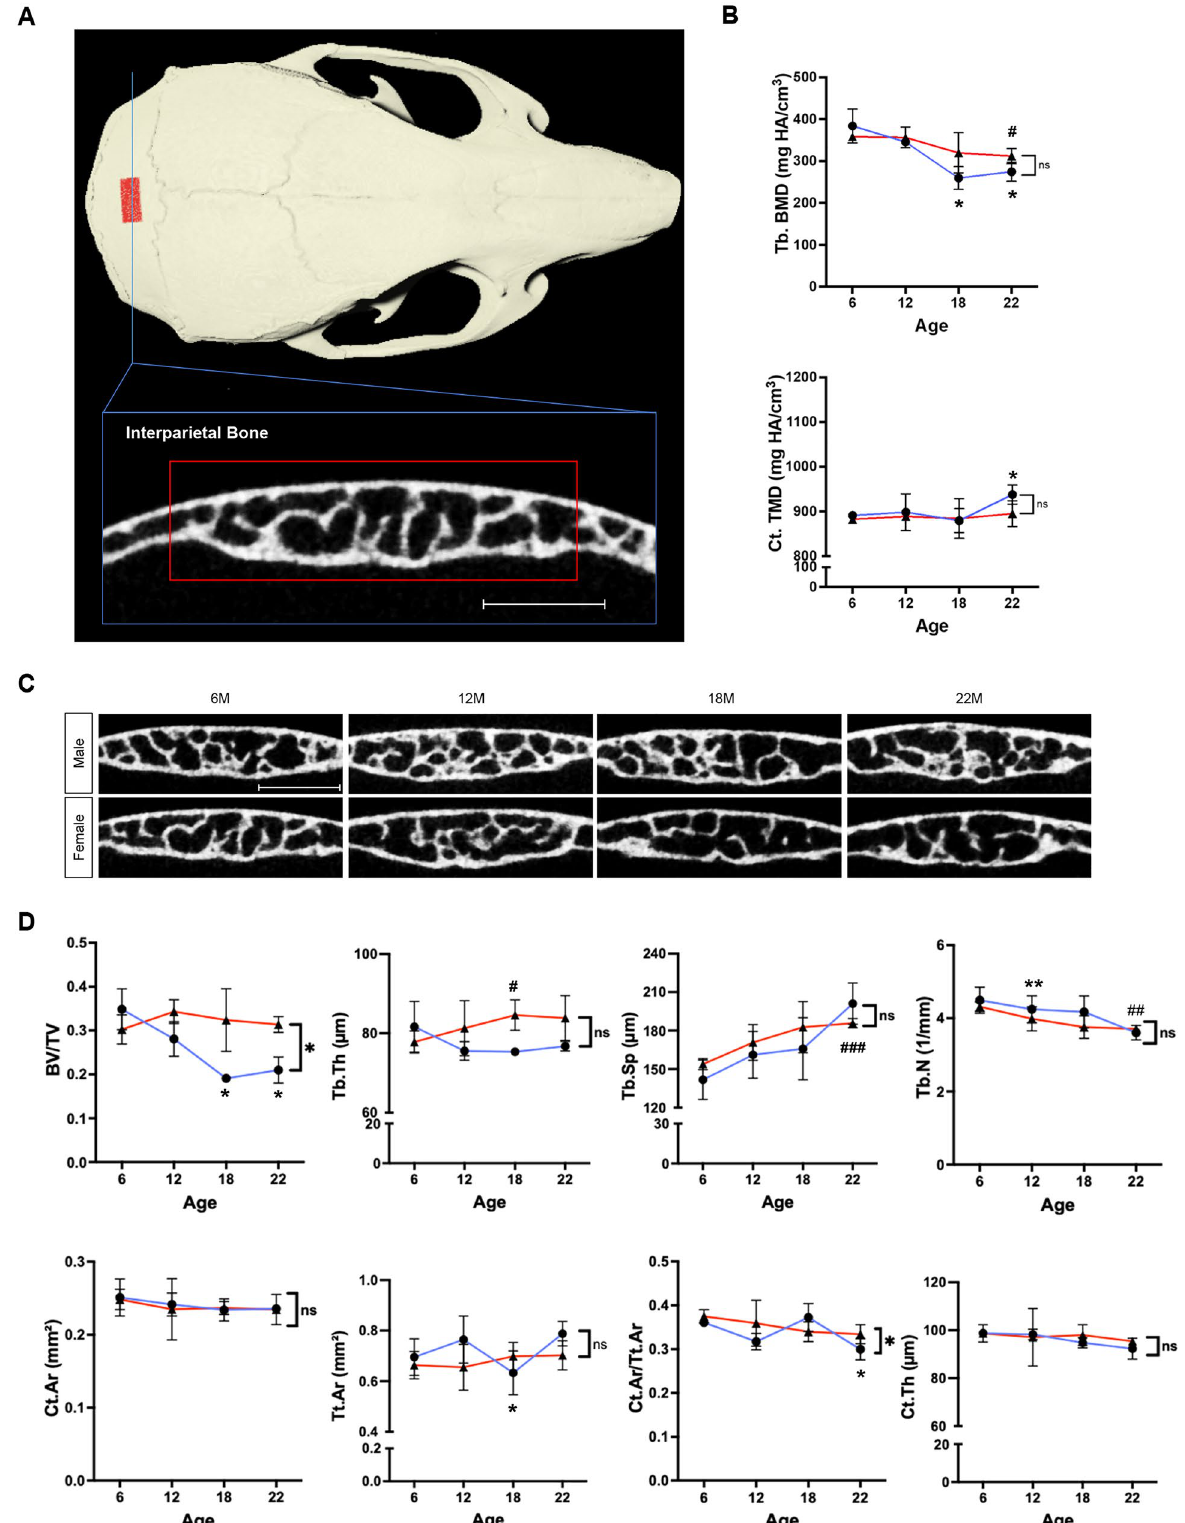
Figure 5. μCT imaging analysis of the interparietal bone. ( A ) 3D reconstruction of the skull and overview of VOI selection for the interparietal bone (red panel). Scale bar, 1 mm. ( B ) Interparietal trabecular bone mineral density as Tb.BMD in mg HA/cm 3 and cortical bone mineral density as Ct.TMD in mg HA/cm 3 for male (blue lines) and female (red lines) mice at 6, 12, 18, 22 months of age. ( C ) Original coronal cross-sectional images of the interparietal bone of male and female mice at 6, 12, 18, and 22 months of age. Scale bar, 1 mm. ( D ) Quantification of morphometric parameters of the interparietal bone of males (blue lines) and females (red lines). Trabecular bone volume fraction (BV/TV), trabecular number (Tb.N, 1/mm), trabecular thickness (Tb,Th, µm), trabecular separation (Tb.Sp, µm), cortical area (Ct.Ar, mm 2 ), total area (Tt.Ar, mm 2 ), cortical area fraction (Ct.Ar/Tt.Ar), and cortical thickness (Ct.Th, µm). n = 3 per group. * p < 0.05, ** p < 0.01, *** p < 0.001 for males; # p < 0.05, ## p < 0.01, ### p < 0.001 for females; ns, not